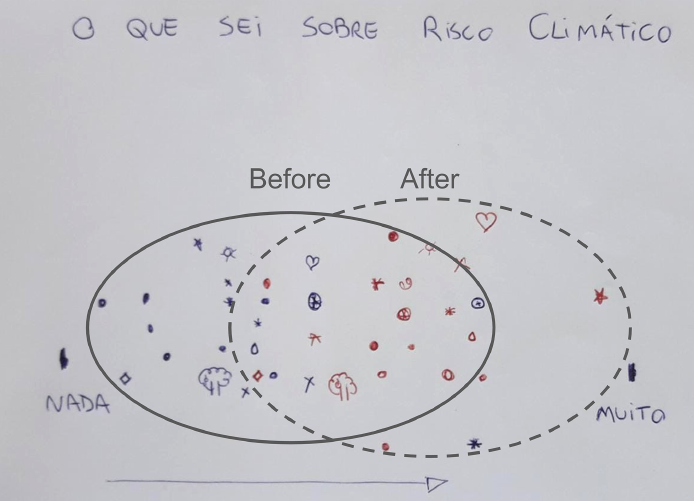
Figure A10. Chart illustrating the evolution of participants’ perception of learning about climate risk in the second training. Each symbol represents a participant, and colours represent the temporality (before and after the lecture). The circle with a continuous line encompasses the perception of the participants at the beginning of the training, whereas the circle with a dashed line embraces the perception at the end of the